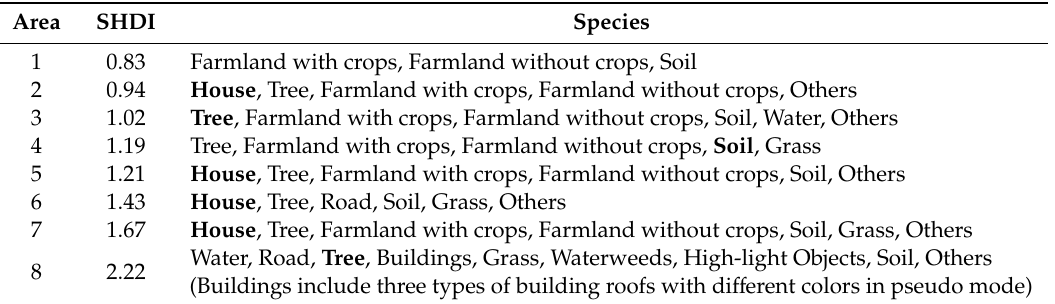
Table 1. SHDI (Shannon diversity index) and species of the 8 study areas (boldface in the table indicates the minority class in the corresponding